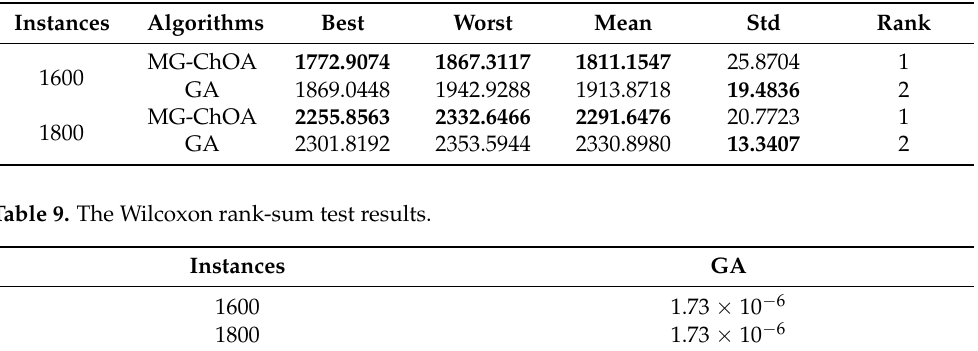
Table 8. Experimental results of algorithms on instances of 1600 and 1800 customers.